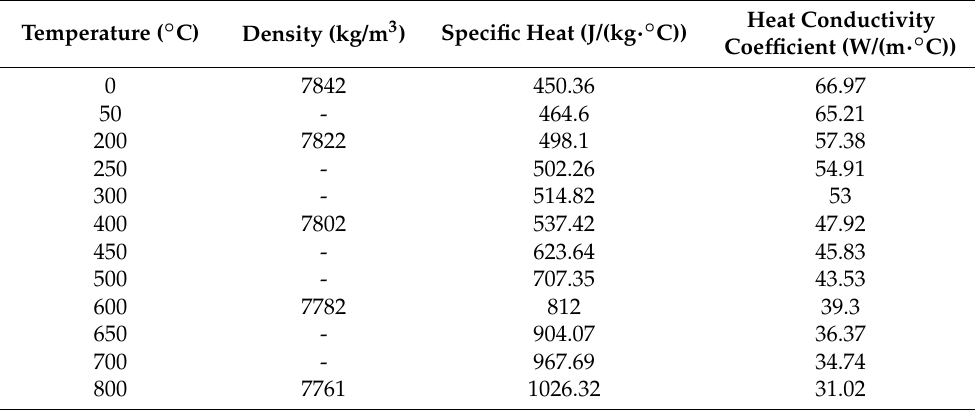
Table 1. Thermal parameters of low carbon